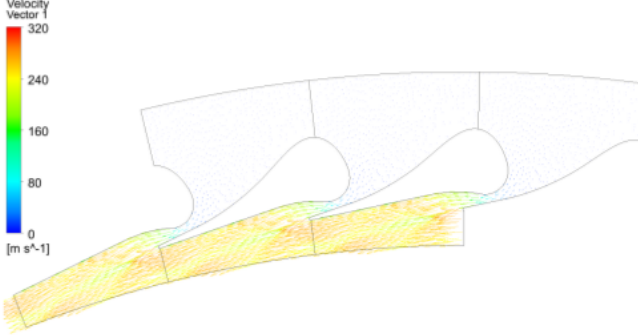
Figure 15: Velocity vectors in the nozzle at 50% of the normalized span.